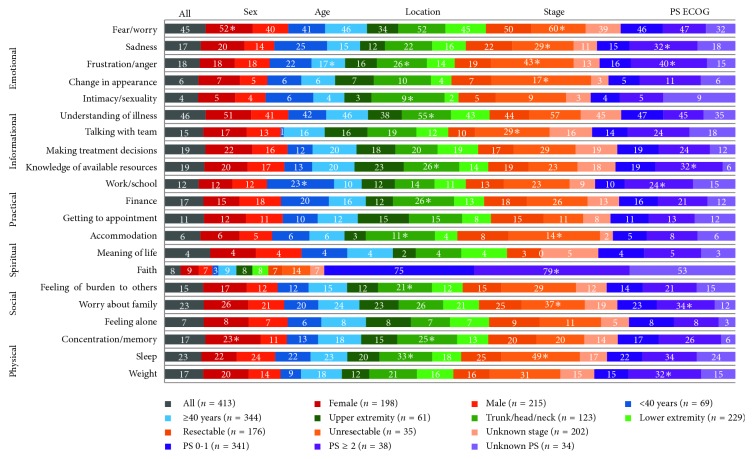
Reported concerns on the Canadian Problem Checklist by patient subgroups. The numbers represent the percentage of patients that reported the concern as positive. PS = performance status; ECOG = Eastern Cooperative Oncology Group; ∗statistically significant with a p value <0.05.